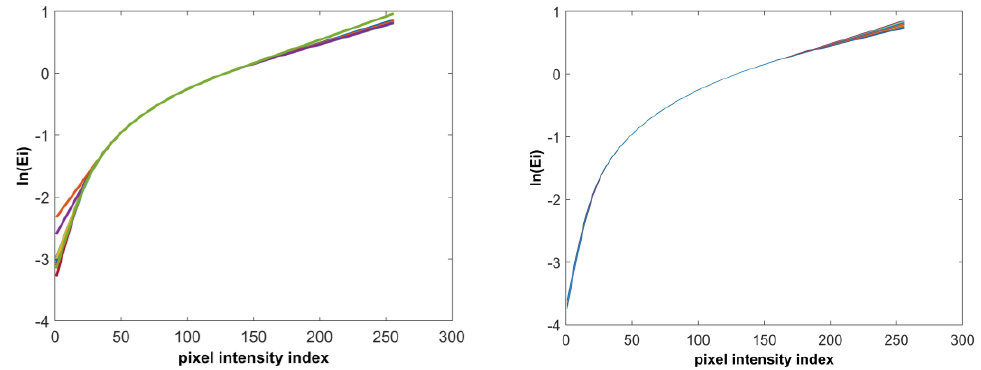
Figure 4. Estimated virtual camera response functions from generated virtual images. Left : Teli dataset; Right : SONY dataset.